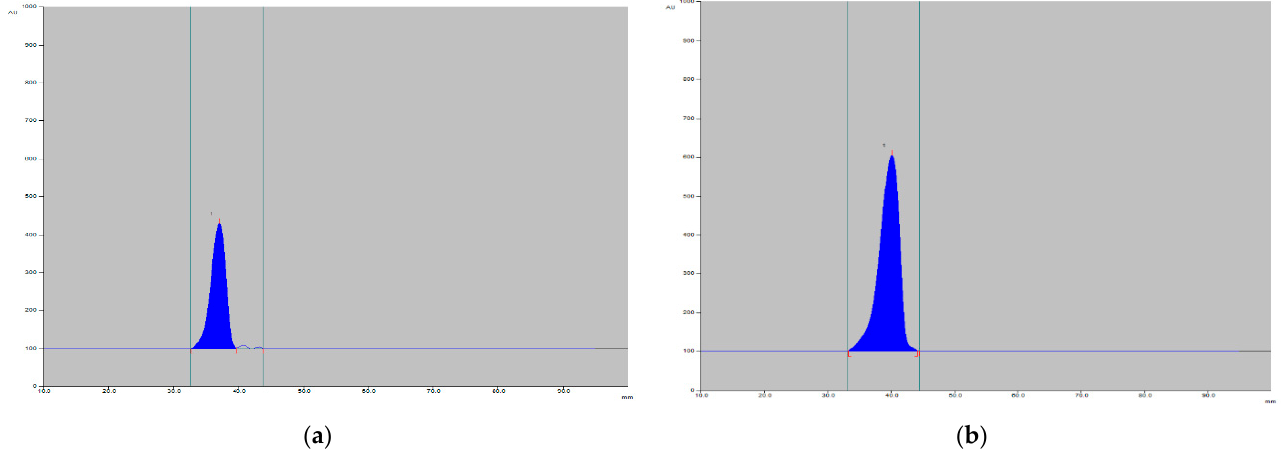
Figure 3. Example densitograms recorded for cefepime in a model mixture containing calcium and bisoprolol at a temperature of 80 °C, after ( a ) 0 h, ( b ) 2 h.